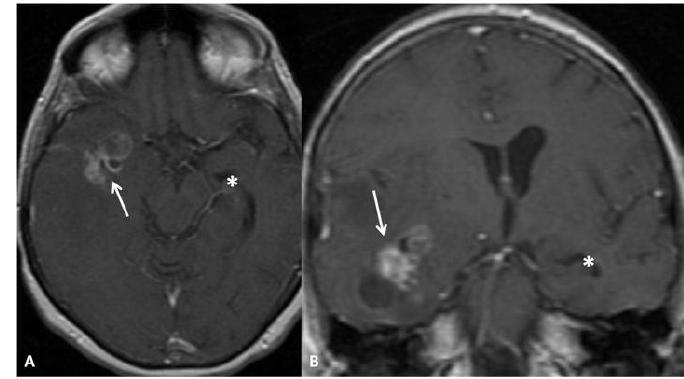
Figure 3. Inconclusive for Ependymal Enhancement on MRI (Group C). Axial (A) and coronal (B) gadolinium-enhanced T1-weighted images showing a right temporal heterogeneously enhancing mass (arrow) compressing the right temporal horn, thereby making it impossible to appreciate ependymal enhancement along it. Note the left temporal horn (asterisk) at the same level.